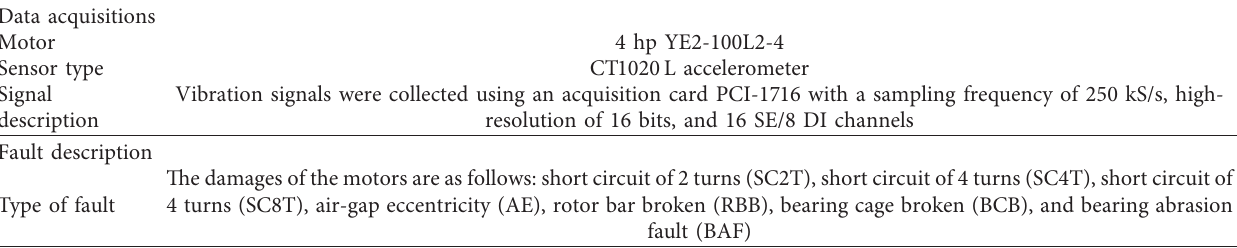
Table 1: Description of the AMCF dataset.